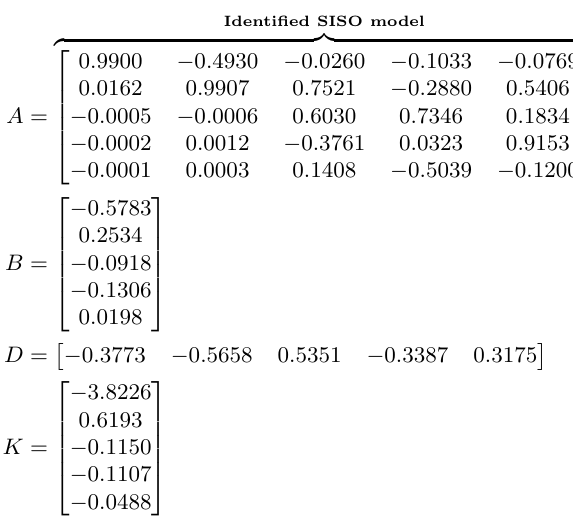
and compared to the validation set, giving MSE = 0 . 9330. Results from a MATLAB script associated with Fig. 3. Case A